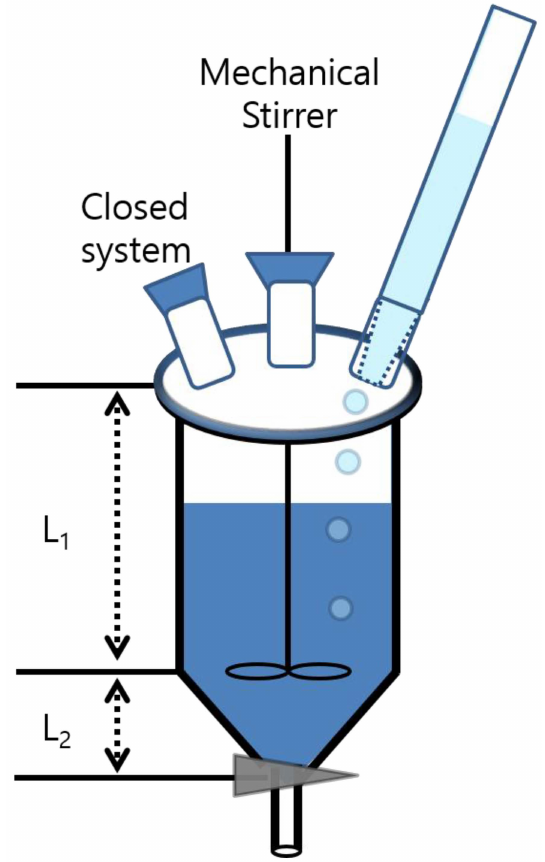
Figure 5. Schematic image of tapered tubular type reactor for continuous flow reaction of